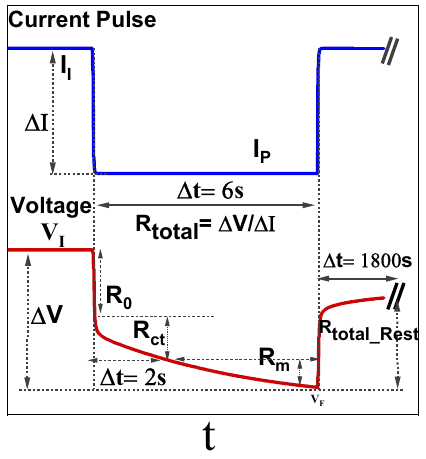
Figure 2. Measurement of internal resistance by DC pulse current.